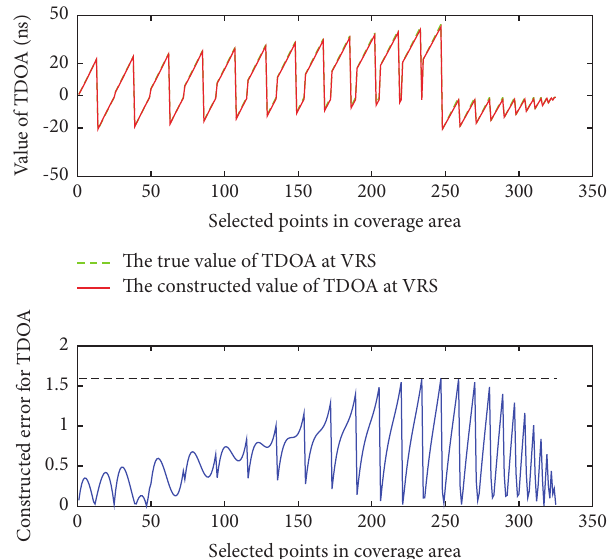
Figure 3: Constructed accuracy for TDOA.